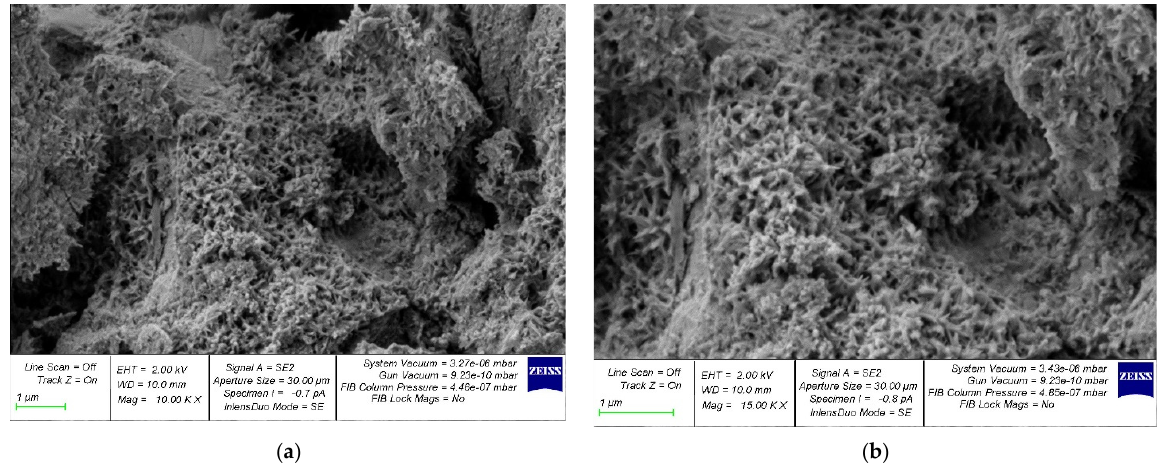
Figure 9. Samples with a nanosilica content of 5.5% by weight of cement with an increase: ( a ) 10,000× and ( b ) 15,000×.